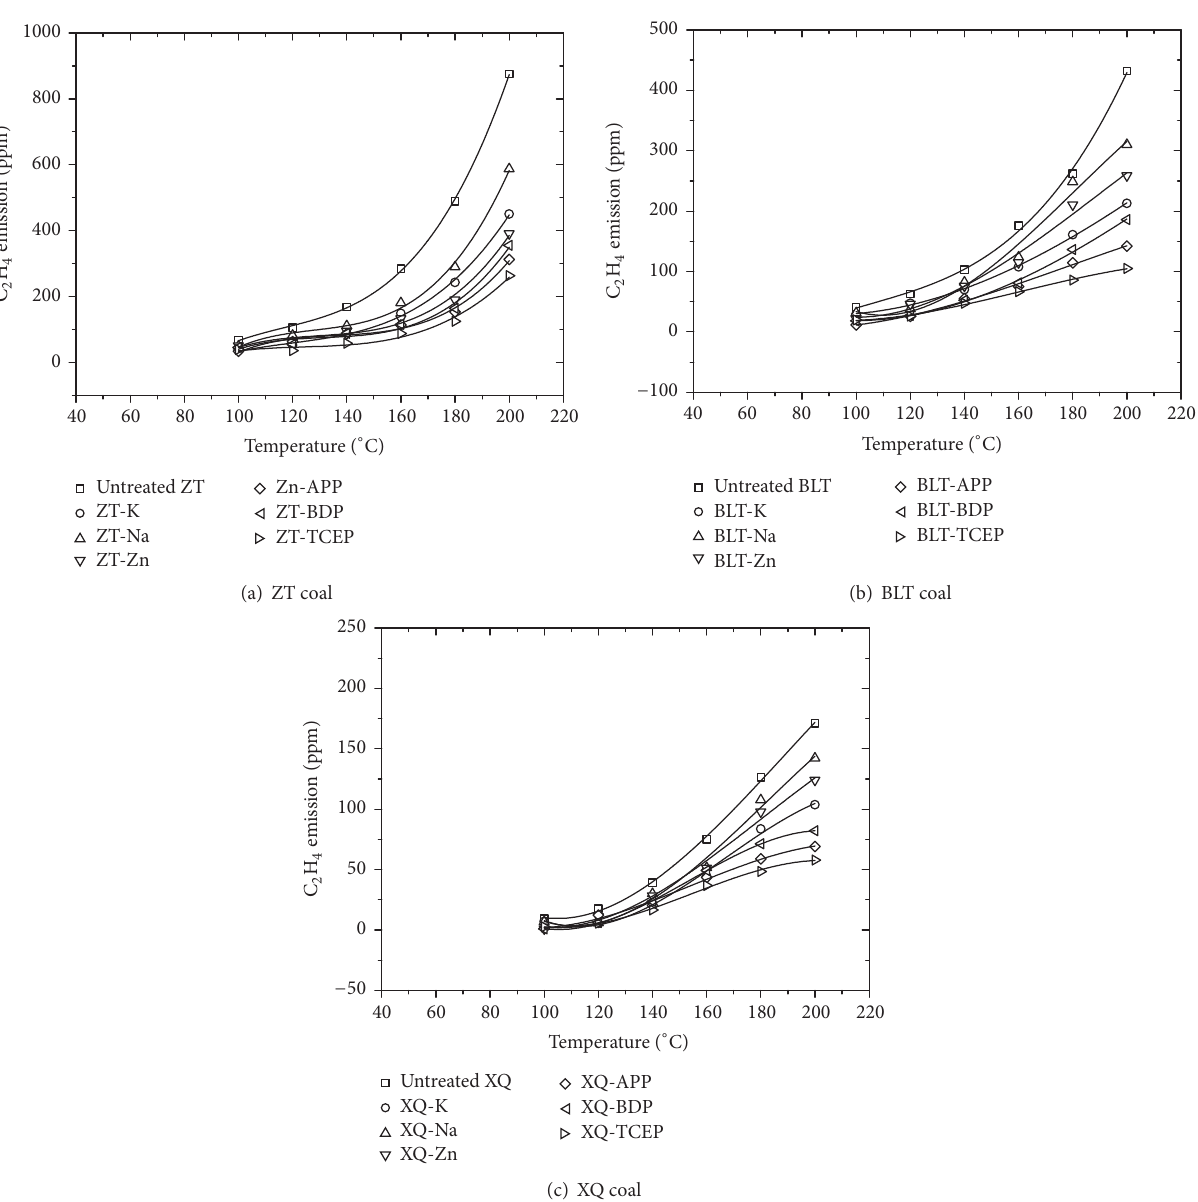
Figure 7: The C 2 H 4 emission of coal samples before and after